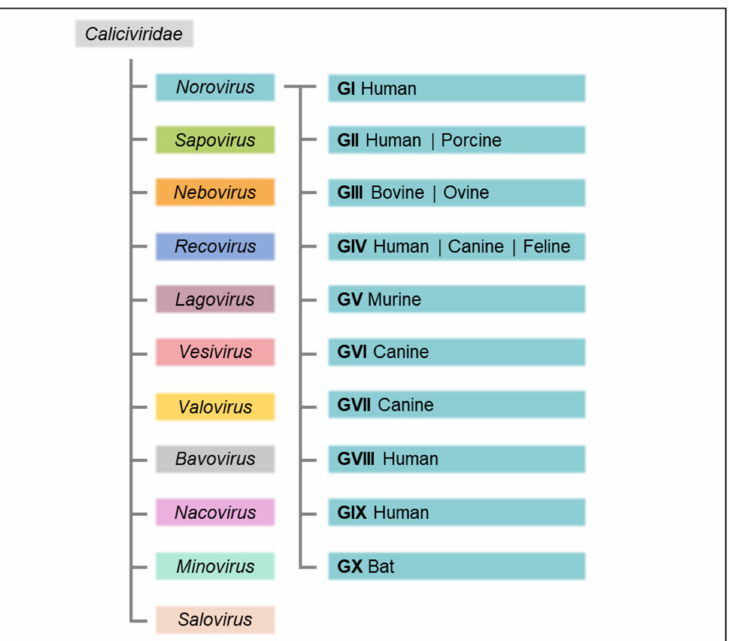
Figure 1. Schematic diagram of the Norovirus genus within the Caliciviridae family. The ten established genera (GI—GX), as defined by Chhabra et al. 2019, are shown, as well as the species wherein each genogroup has been